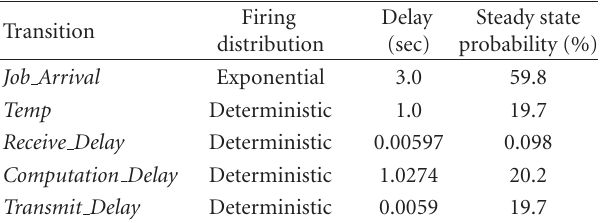
Table 10: Results of actual system and petri